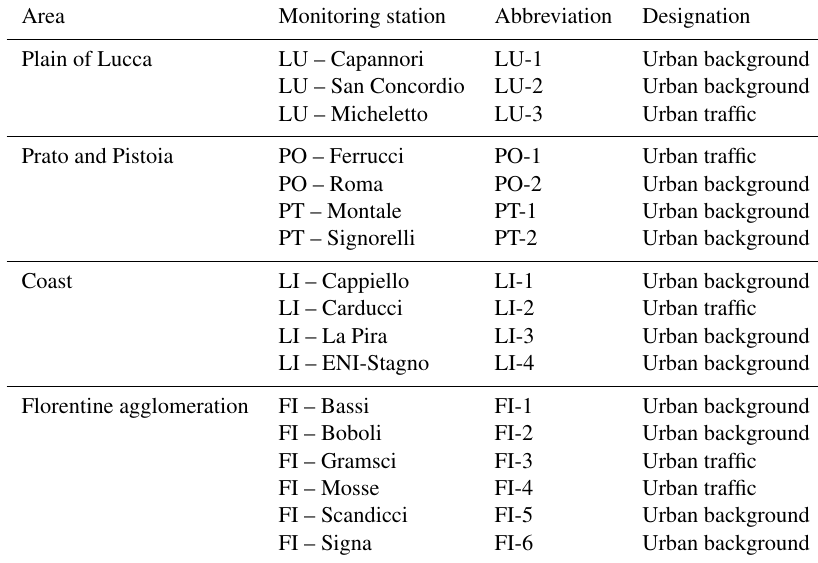
Table 1. List of the 17 sampling sites.